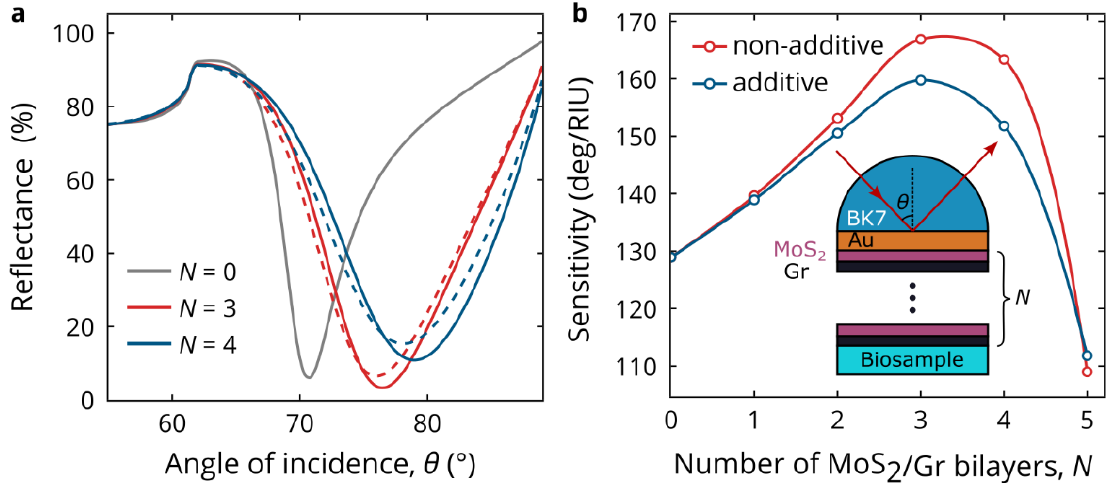
Figure 6. SPR biosensor performance. ( a ) Angle-resolved reflectance for different number N of MoS 2 /Gr bilayers deposited on gold layer. Dashed and solid lines were calculated using the additive and non-additive dielectric functions of MoS 2 , correspondingly. ( b ) Angular sensitivity of the biosensor as a function of N calculated with the additive (blue line) and non-additive (red line) dielectric functions of MoS 2 . Inset: schematic view of the studied biosensor. The thickness of gold is 40 nm, and the operating wavelength is 635 nm.